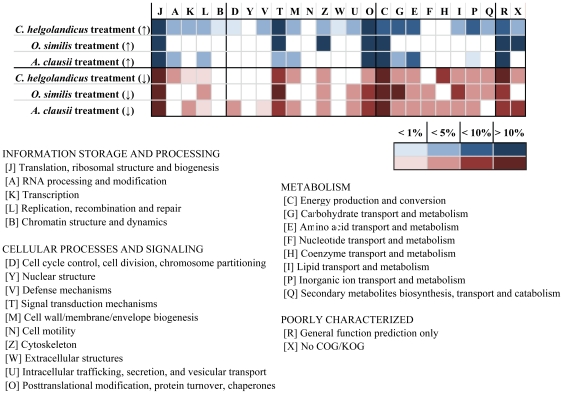
KOG category distributions of differential expressed ESTs identified through microarray hybridizations.The table displays the KOG category distribution of up (↑) and down (↓) regulated ESTs in comparison to a control treatment. The color strengths displays the amount of ESTs per group calculated in percent from total ESTs grouped into KOGs with known or general function prediction.